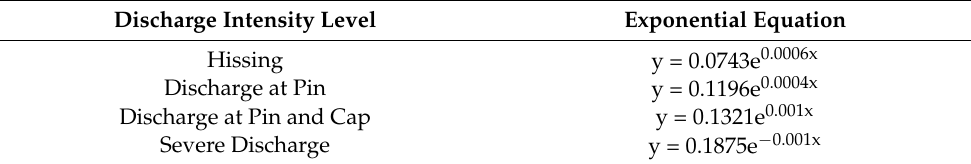
Figure 10. Average DC component for each level of discharge intensity at different contaminations levels. Table 5. Exponential equation for each discharge intensity level with respect to insulator samples’ contamination